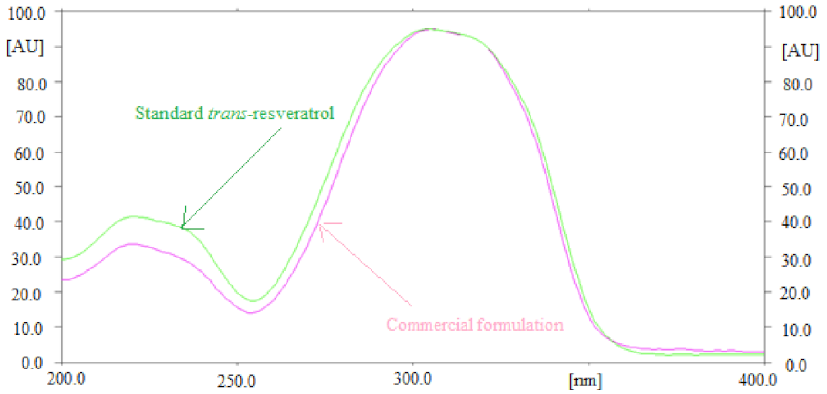
Figure 2. Overlaid ultraviolet (UV) absorption spectra of standard TRV and TRV in marketed capsule dosage